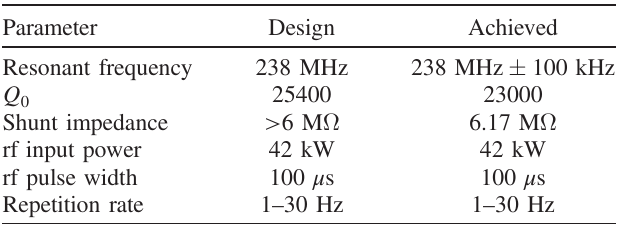
TABLE II. The main rf parameters of the 238-MHz rf cavity